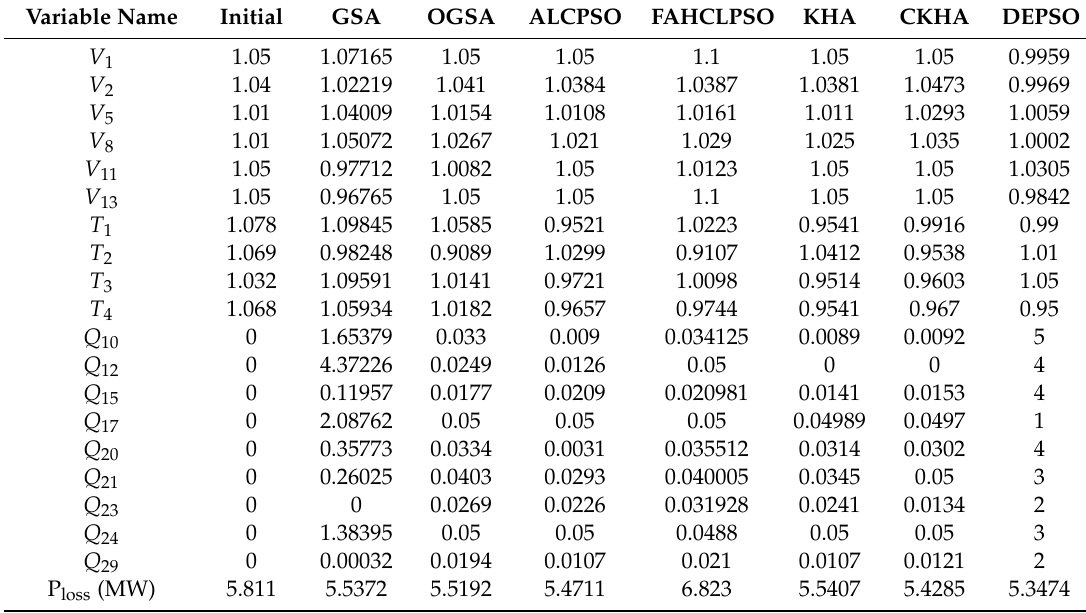
Table 6. Optimal control variables and power loss for IEEE 30-bus using di ff erent